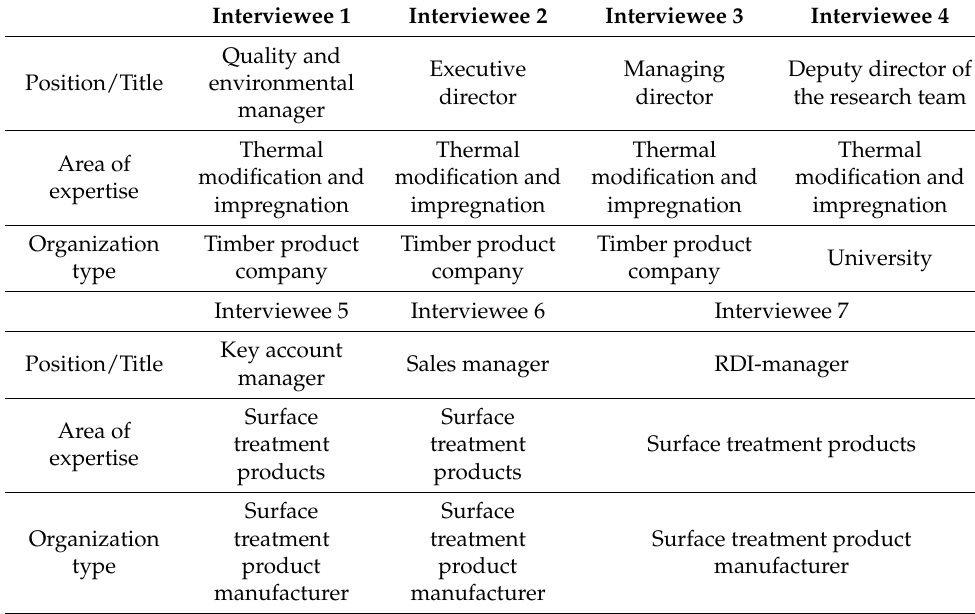
Table 1. Interviewees by their position/title, area of expertise, and organization